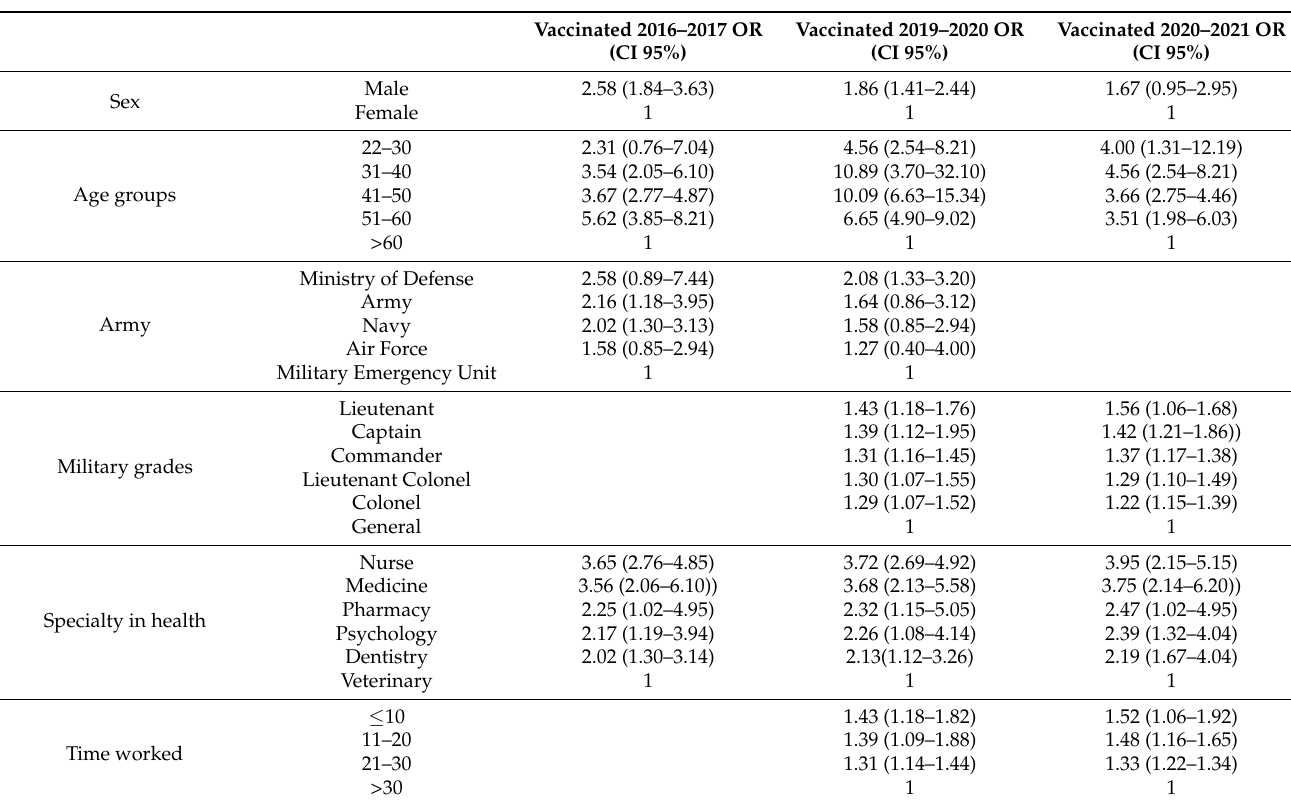
Table 2. Predictors of influenza vaccination uptake high risk